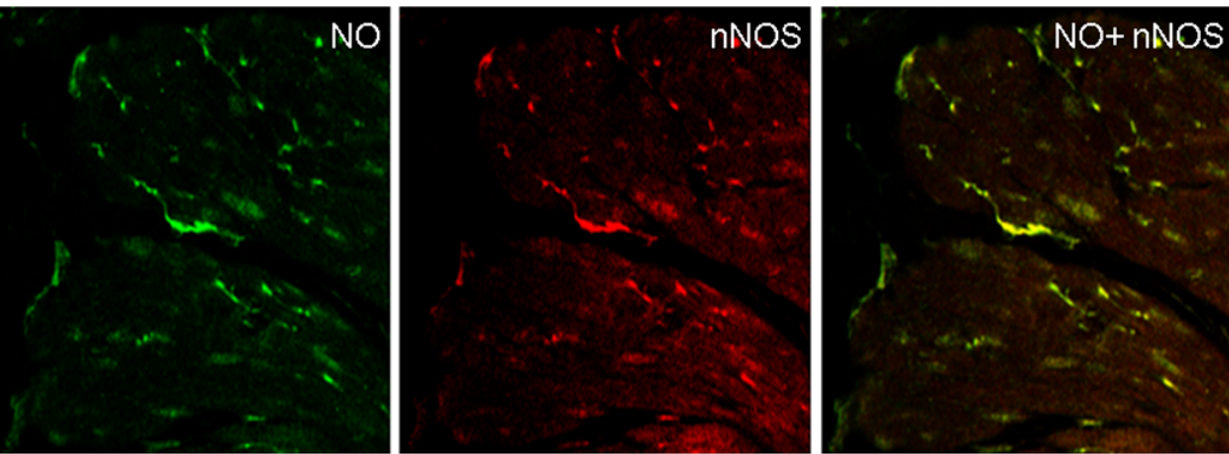
Figure 3. Colocalization of NO and Ca 2 + in the varicosities. The muscle strip simultaneously preloaded with calcium orange and DAF-2A were electrically stimulated and the varicosities were examined for Ca 2 + and NO signals. Top panel shows green NO positive varicosities. Middle panel shows orange-red calcium positive varicosities. Bottom panel shows colocalized NO and Ca 2 + signals. Neither NO nor Ca 2 + signals were seen in the neighboring smooth muscle cells. (320 6